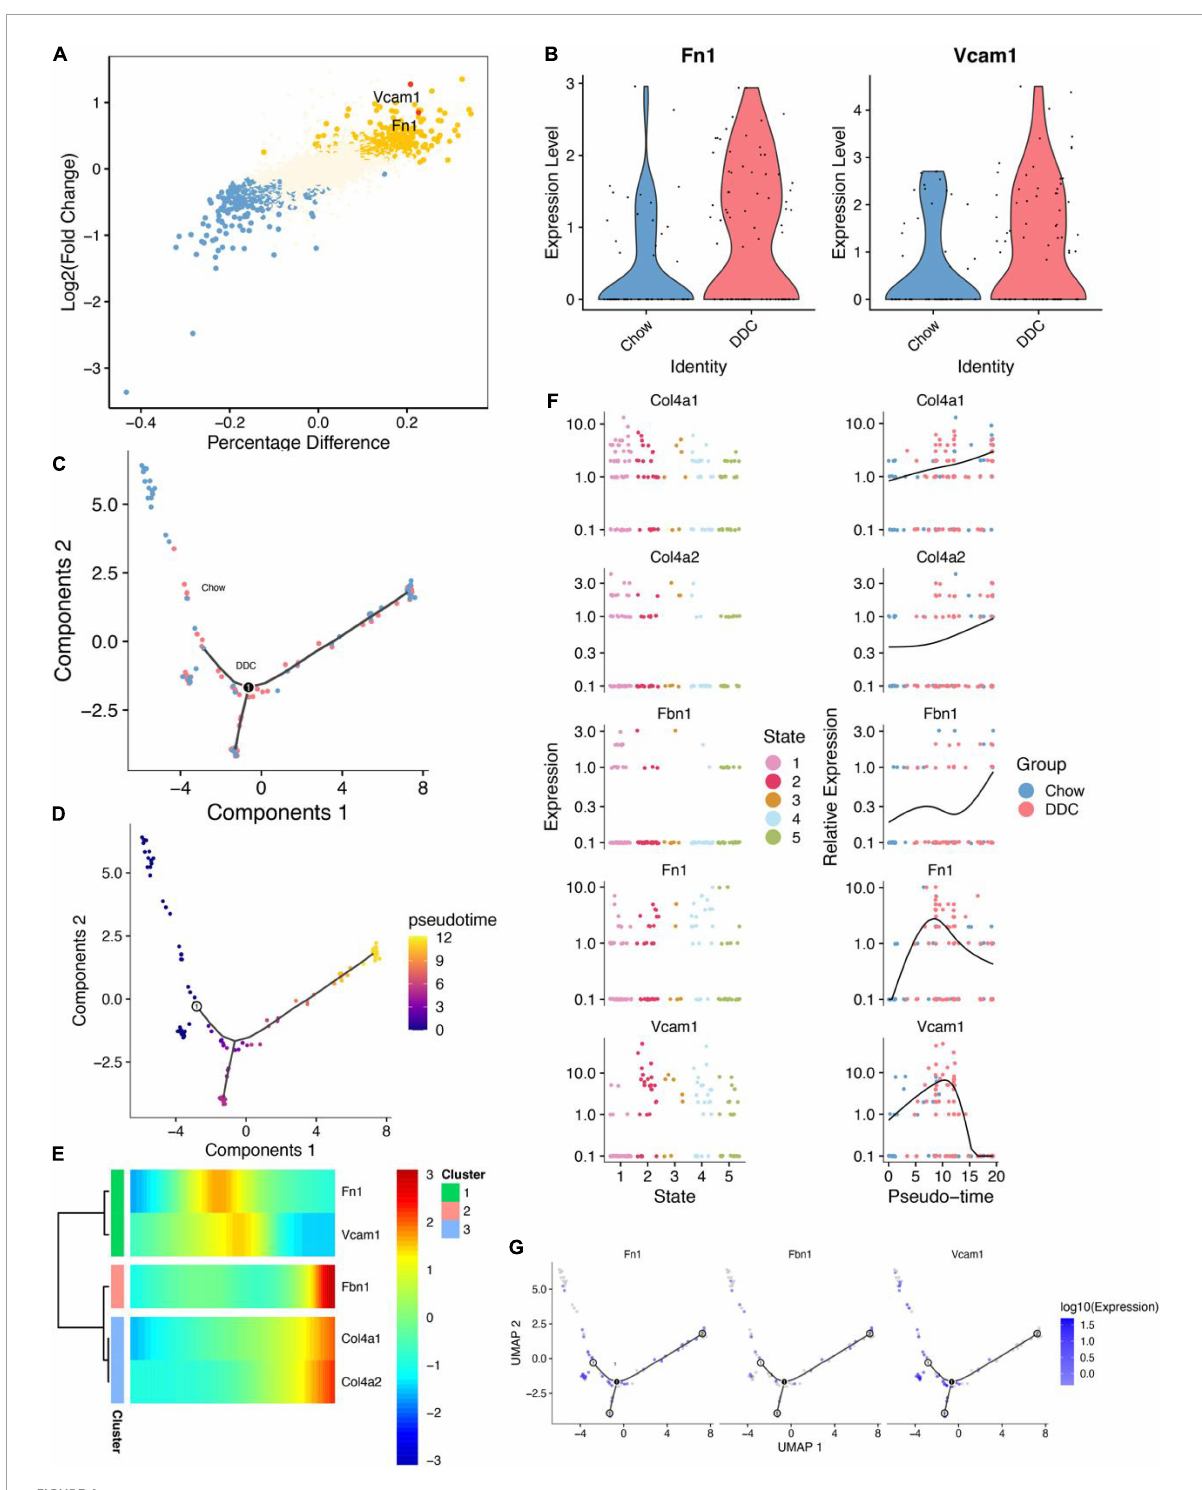
FIGURE4 Cell trajectory inference analysis of EC_EndMT. (A) The results showed differential analysis of Vcam1 and Fn1. (B) Vcam1 and Fn1 were upregulated in DDC group compared to Chow group. (C) DDRTree plot showed the distributions of EC_EndMT subtypes between Chow and DDC groups. (D) DDRTree plot of pseudotime of EC_EndMT subtypes. (E) Expressions of 5 important genes in EC_EndMT were accompanied by changes in the sorting of pseudotime. (F) Expressions of these five important genes between cell states (left), and their expressions were accompanied by changes in the sorting of pseudotime (right). (G) DDRTree plots for Fn1, Fbn1, and Vcam1 expressions in